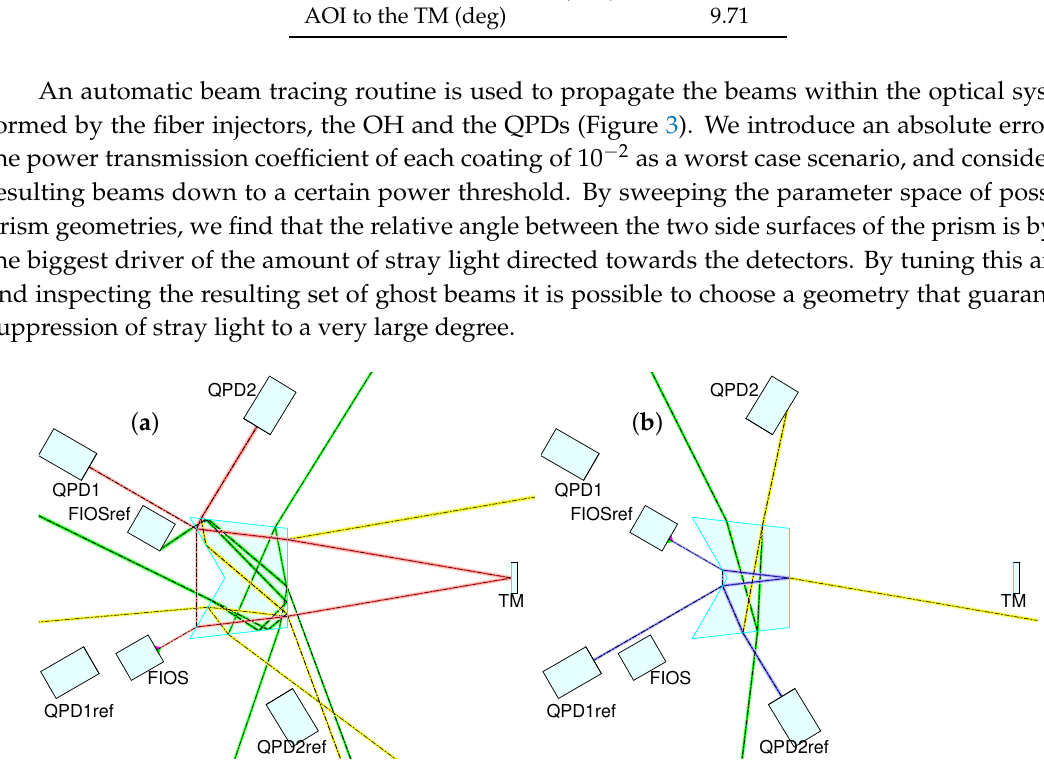
Figure 3. Ghost beam suppression in test mass inertial sensing interferometer (TM IFO) ( a ) and reference interferometer (Ref IFO) ( b ). Beams resulting from unwanted reflections or transmissions in the optic may interfere with the nominal interferometric beams and spoil the measurement. The relative angle between the side surfaces is optimized via simulation to yield a configuration where ghost beams down to a certain power threshold are kept from impinging the detectors. Shown in red and blue are the nominal beams of the test mass and the reference interferometer, respectively, in the already optimized optical head. Absolute errors of 10 − 2 are introduced in the power transmission coefficient of each surface, and ghost beams down to a power threshold of 10 − 12 relative to the nominal beam power are considered. In this plot we represent ghost beams at the 10 − 3 (yellow) and 10 − 7 (green) relative power levels for the sake of clarity, see the Appendix A for a more complete